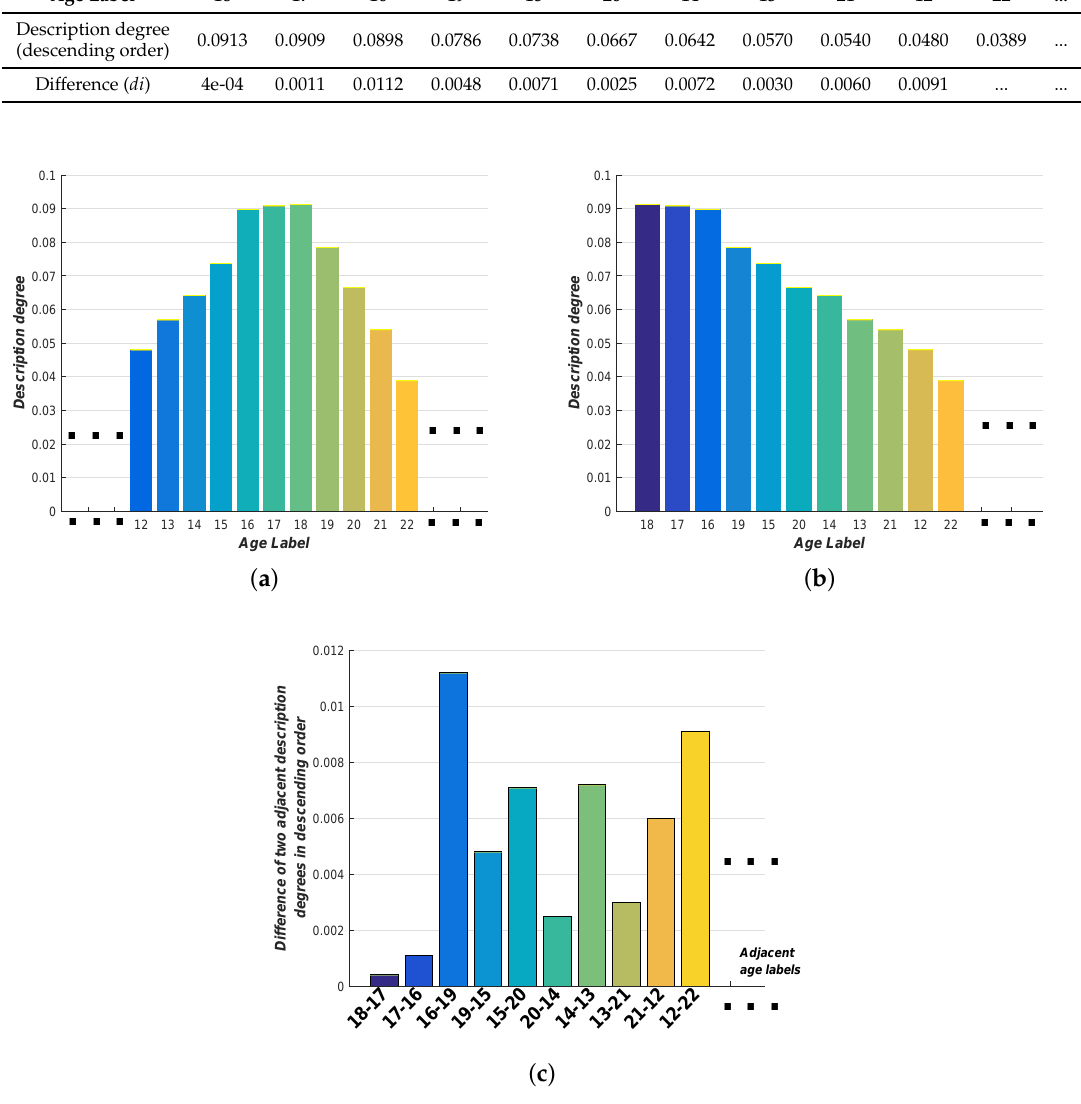
Figure 4. Histogram illustrations for the example of Tables 1 and 2: ( a ) corresponds to Table 1; ( b ) and ( c ) correspond to Table